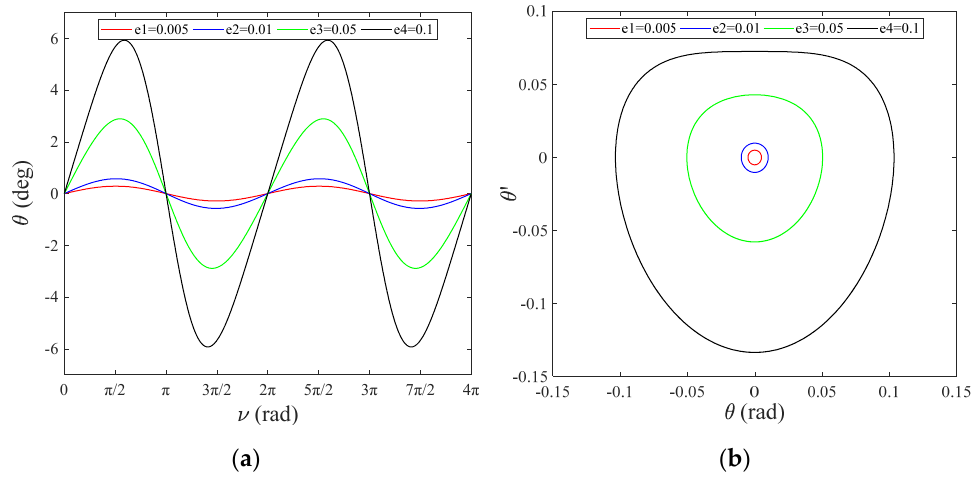
ν ; ( b ) angular velocity of the in-plane angle, θ′ ,